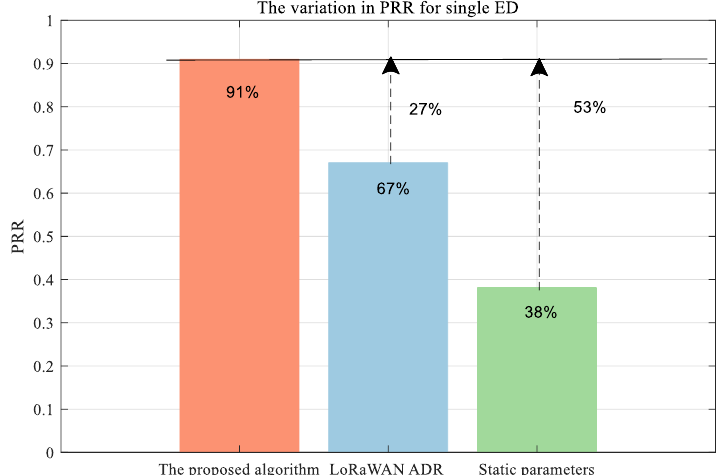
Figure 14. Algorithm comparison.